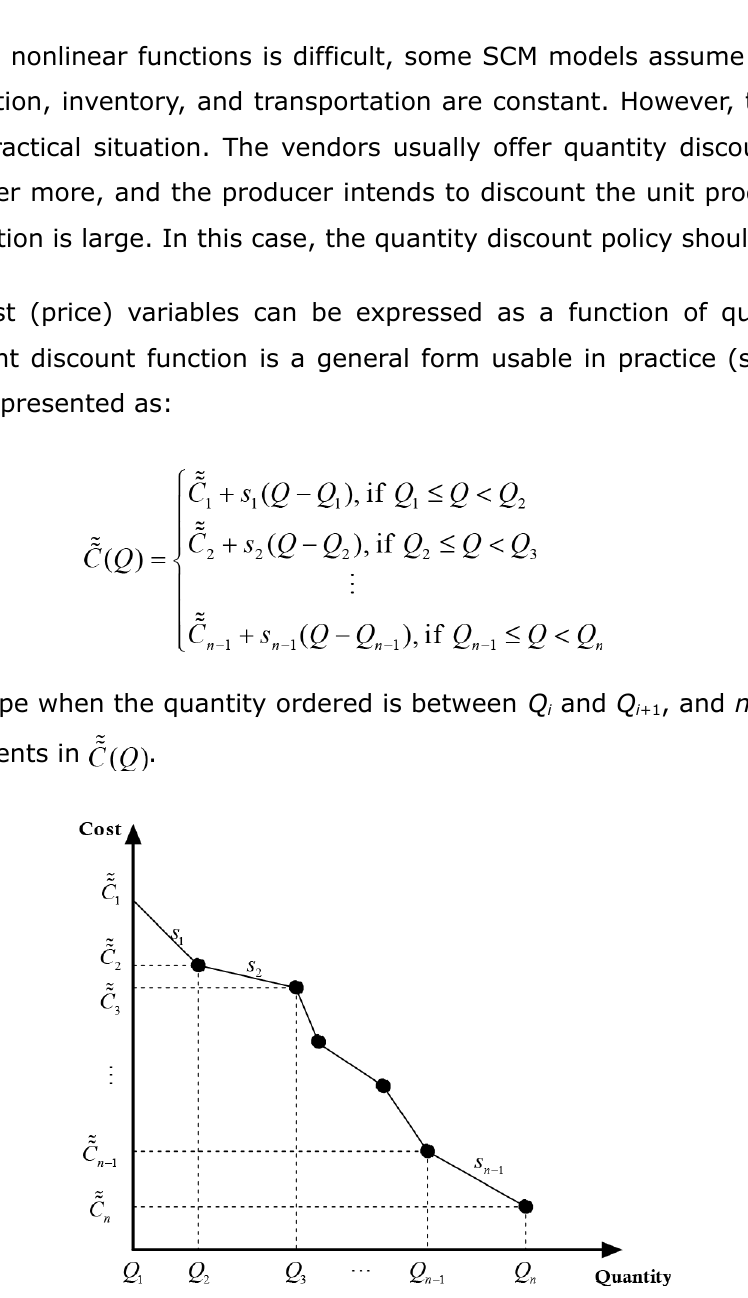
Figure 2. Multiple breakpoint discount